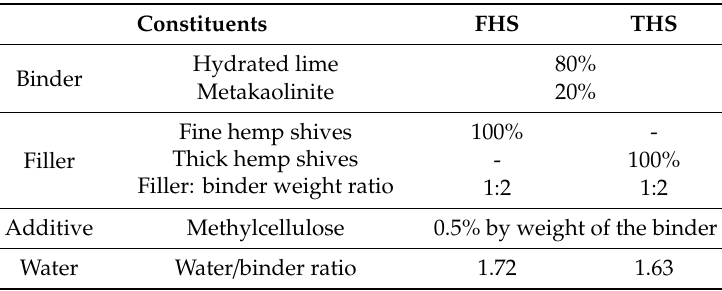
Table 2. Mass fractions of constituents in examined mixtures.